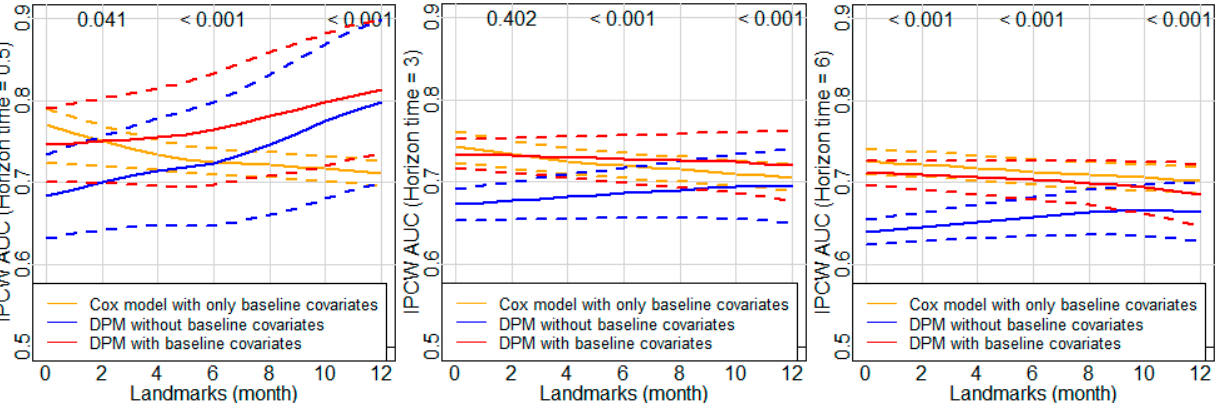
Figure A4. IPCW AUC and its 95% CI for the DPM using time-dependent ECOG PS assessed at horizon time of 0.5 month (left), 3 months (middle), and 6 months (right). P values at the top of each plot are for comparing the DPM using both time-dependent ECOG PS and baseline covariates and the baseline Cox model at landmarks of 2, 6, and 12 months.